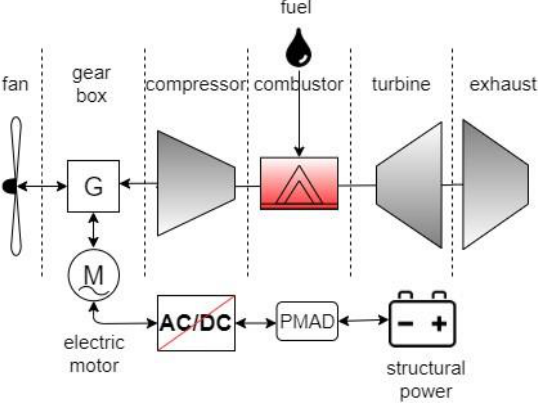
Figure 1. A hybrid-electric aircraft propulsion system with parallel architecture.